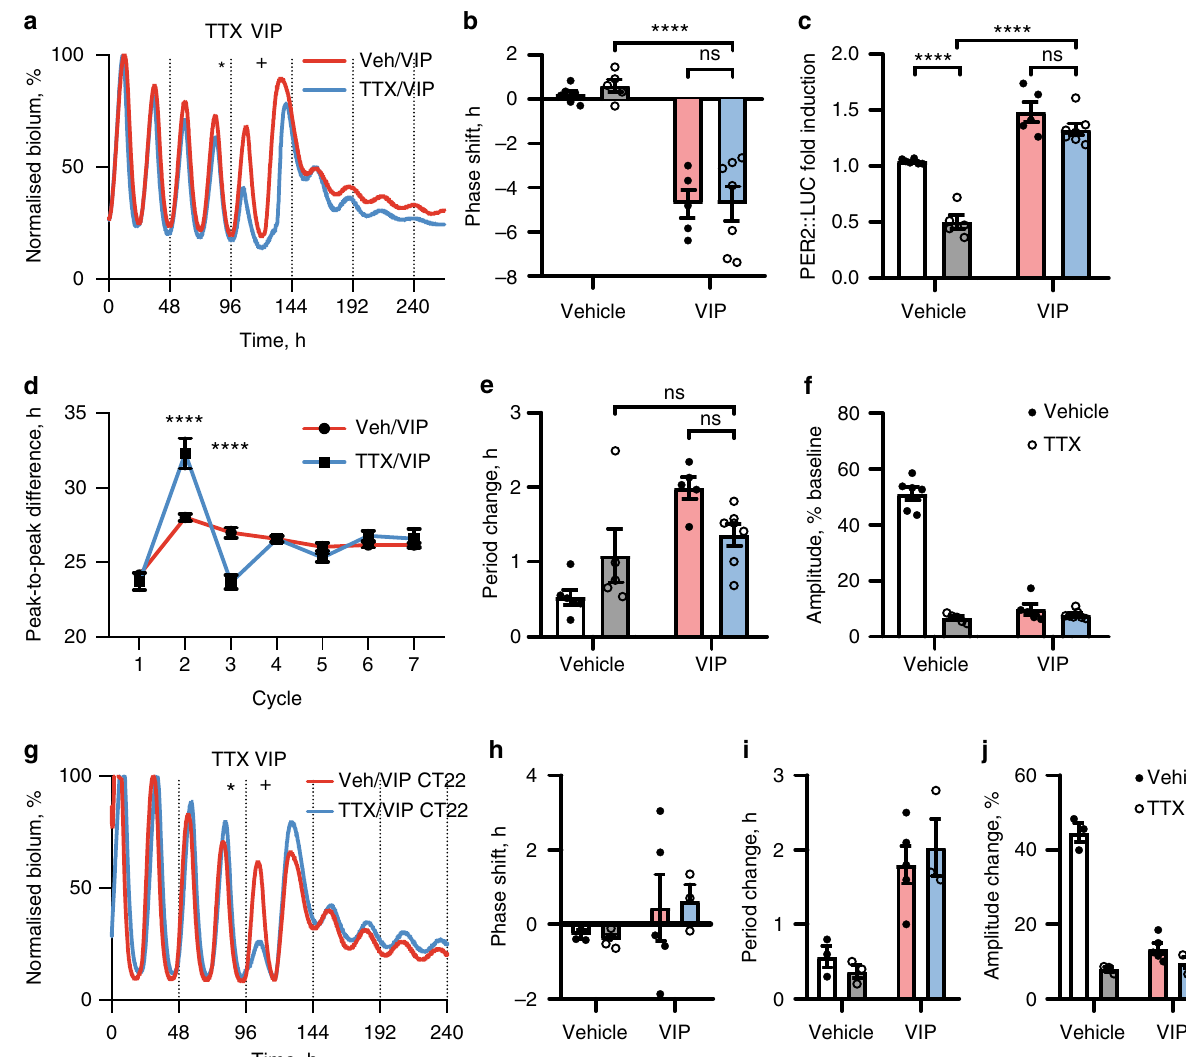
Fig. 2 VIP re-programmes the electrically silenced SCN network. a Representative PER2::LUC bioluminescence rhythms of SCN slices treated with 10 µ M VIP at CT10 (marked by plus), after vehicle or 1 µ M tetrodotoxin (TTX) 24 h earlier (marked by asterisk). Bioluminescence was normalised to the fi rst peak. b , c Group data for phase shift ( b ) and acute fold induction of PER2::LUC ( c ) responses relative to predicted values after treatments (mean ± SEM; Veh/ Veh ( n = 6), TTX/Veh ( n = 5), Veh/VIP ( n = 5), TTX/VIP ( n = 7). d Peak-to-peak period following treatments (mean ± SEM). VIP was added between cycles 1 and 2. e , f Group data for period ( e ) and amplitude ( f ) responses after treatments (mean ± SEM; n as in b and c . g Representative PER2::LUC bioluminescence rhythms of SCN slices treated with 10 µ M VIP at CT22 (marked by plus), after vehicle or 1 µ M tetrodotoxin (TTX) 24 h earlier (marked by asterisk). h – j Group data for phase shift ( h ), period change ( i ) and amplitude ( j ) responses after VIP at CT22 preceded by TTX/vehicle (mean ± SEM; Veh/ Veh ( n = 3), TTX/Veh ( n = 3), Veh/VIP ( n = 5), TTX/VIP ( n = 3). All tests two-way ANOVA with Sidak ’ s ( d ) or Tukey ’ s ( b , c , e , f ) multiple comparisons test, ns = not signi fi cant, **** P <